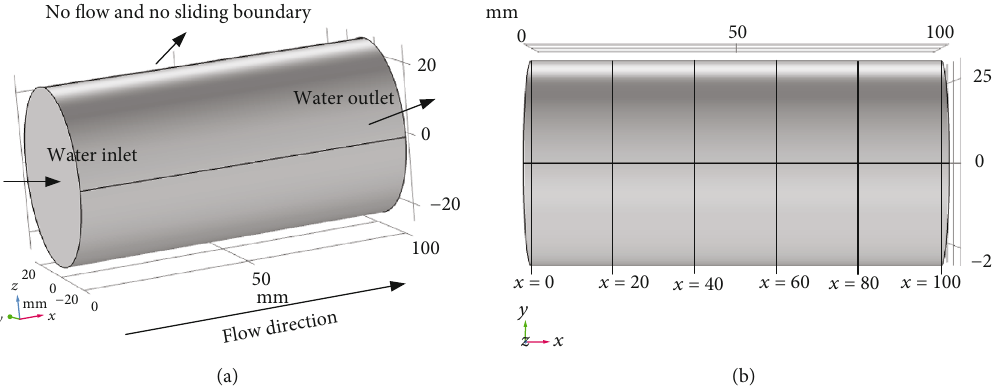
Figure 8: Seepage model. (a) Seepage model of heat-treated red sandstone. (b) Section division of the seepage path length